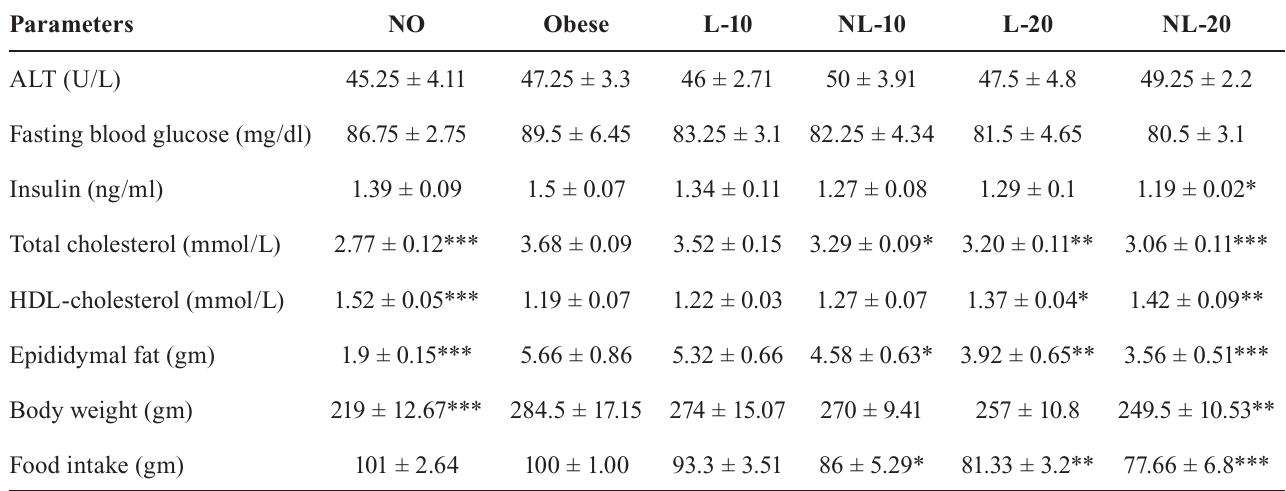
TABLE III - Physiological and biochemical parameters for the different groups and time points: none-obese (NO) obese untreated (obese), Lupine crude oil treated after 10 days (L-10) and 20 days (L-20), and lupine oil nanoemulsion formulation after 10 days (NL-10) and 20 days (NL-20). Values are mean ± SD (n = 5)